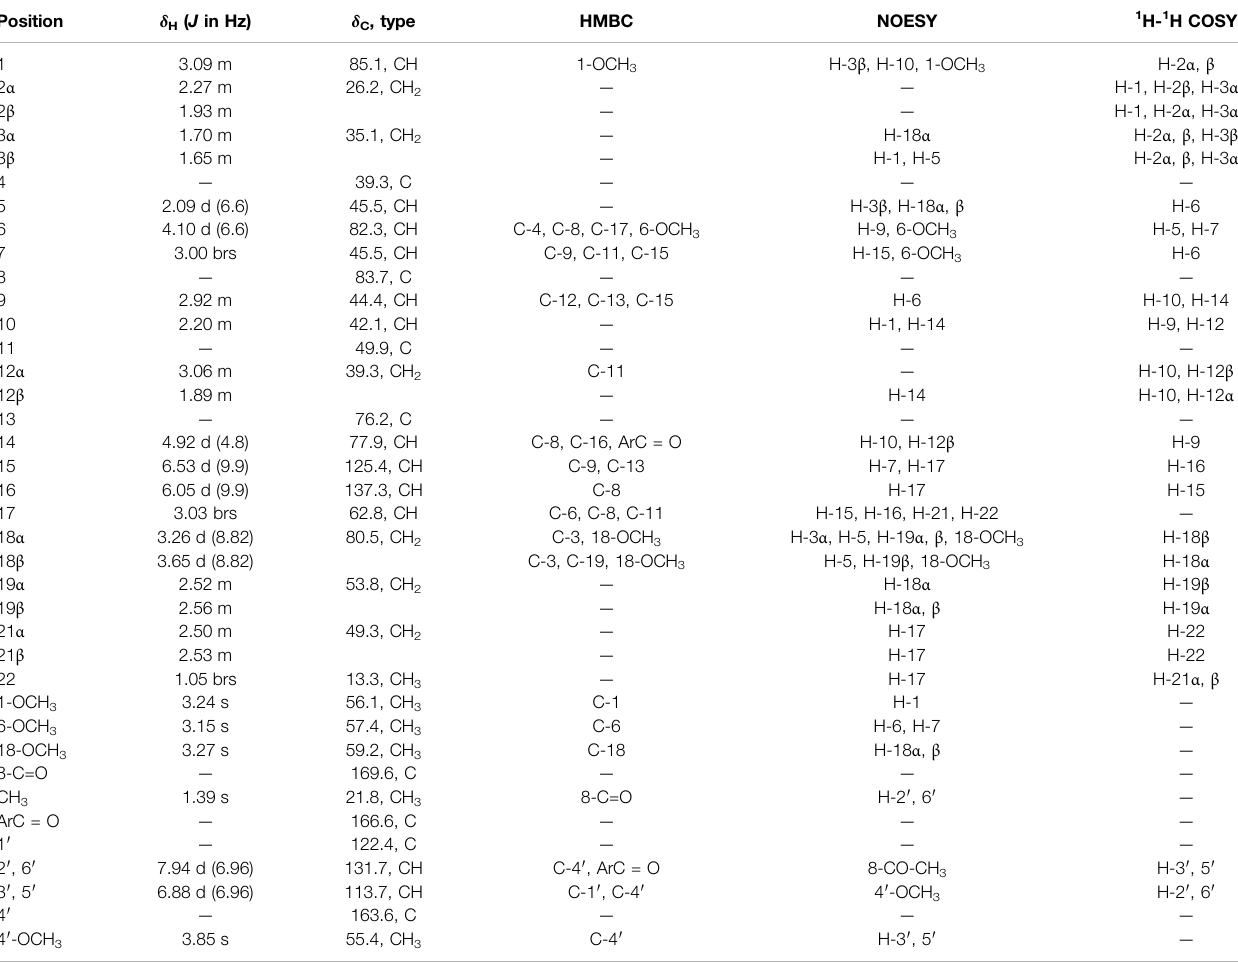
TABLE 3 | 1 H (600 MHz) and 13 C (150 MHz) NMR data for compound 3 (CDCl 3 ).